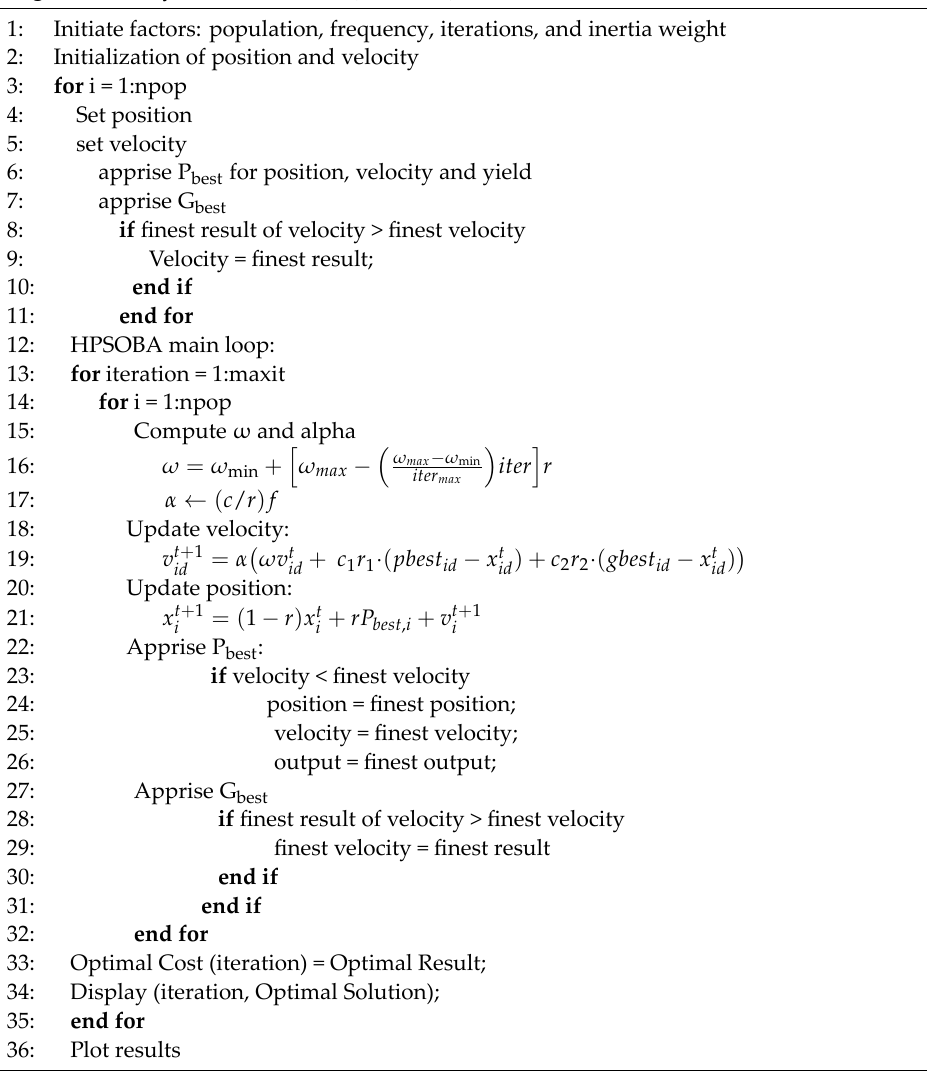
Algorithm 1. Hybrid PSO and BA